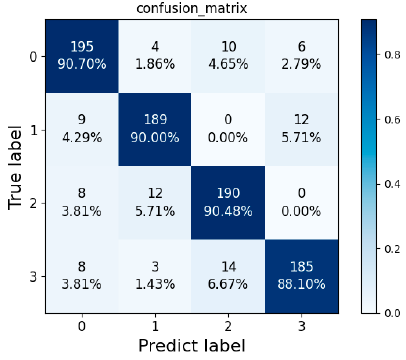
Figure 13. Alex classification model.